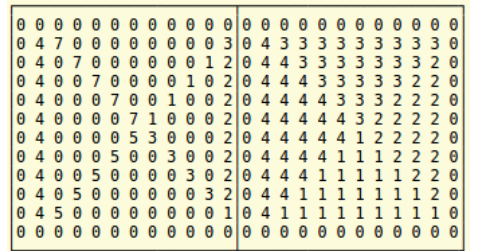
Fig. 8: Sparse boundary grid generated from the vector dataset in Fig. 7 (left), and the resulting full area grid after applying xor prefix (right)